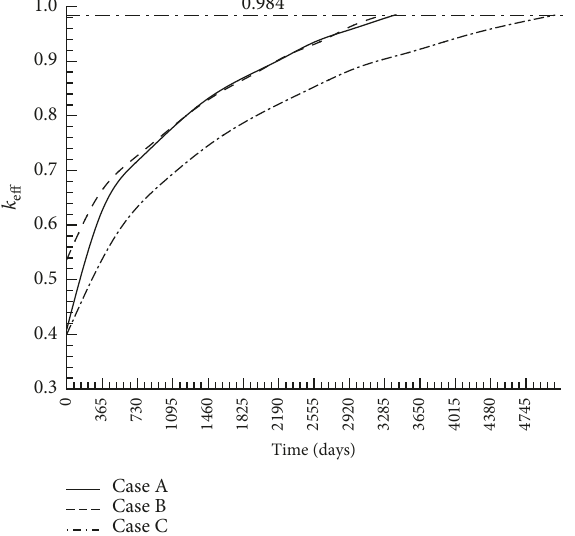
Figure 2: Increase in the effective neutron multiplication factor depending on the operation